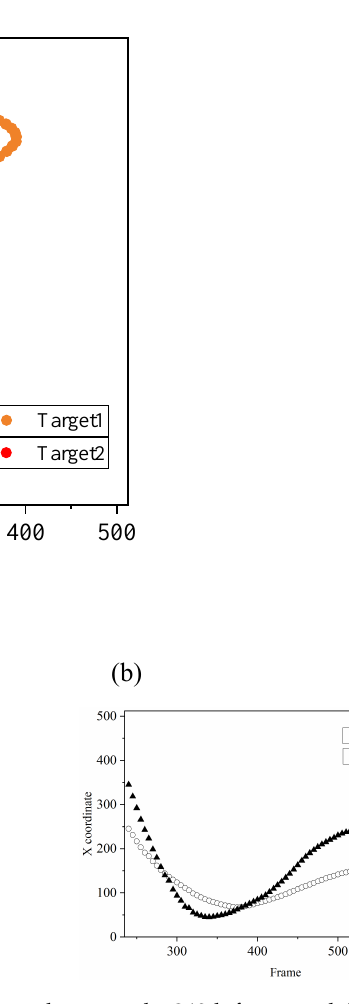
Figure 12. The estimated results of coordinates between the 240th frame and the 630th frame: ( a ) is the yellow ball, and ( b ) is the red